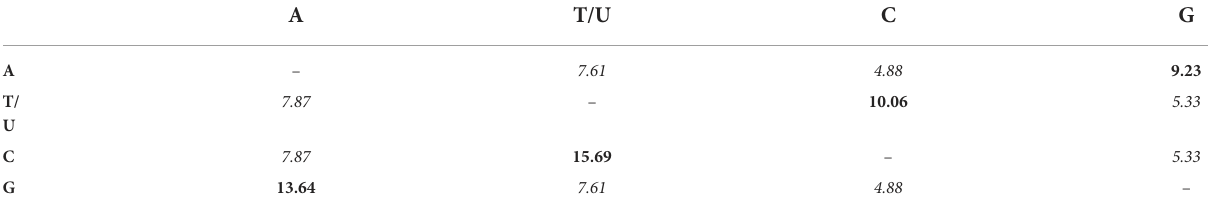
TABLE 10 Maximum likelihood estimate of substitution matrix of